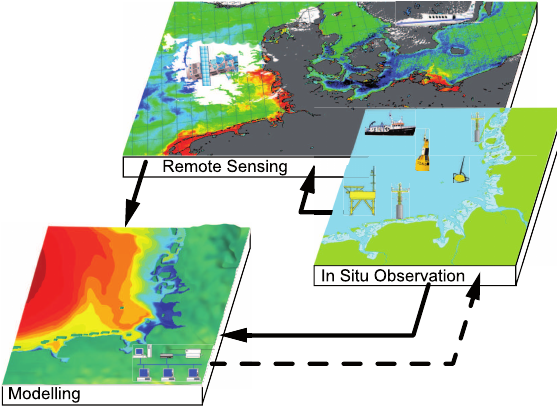
Fig. 2. Observation and modelling suite. The arrows illustrate the flow of information between in situ, remote sensing observations and numerical models. Dashed arrow illustrates possible contribu- tion of models in optimising observational